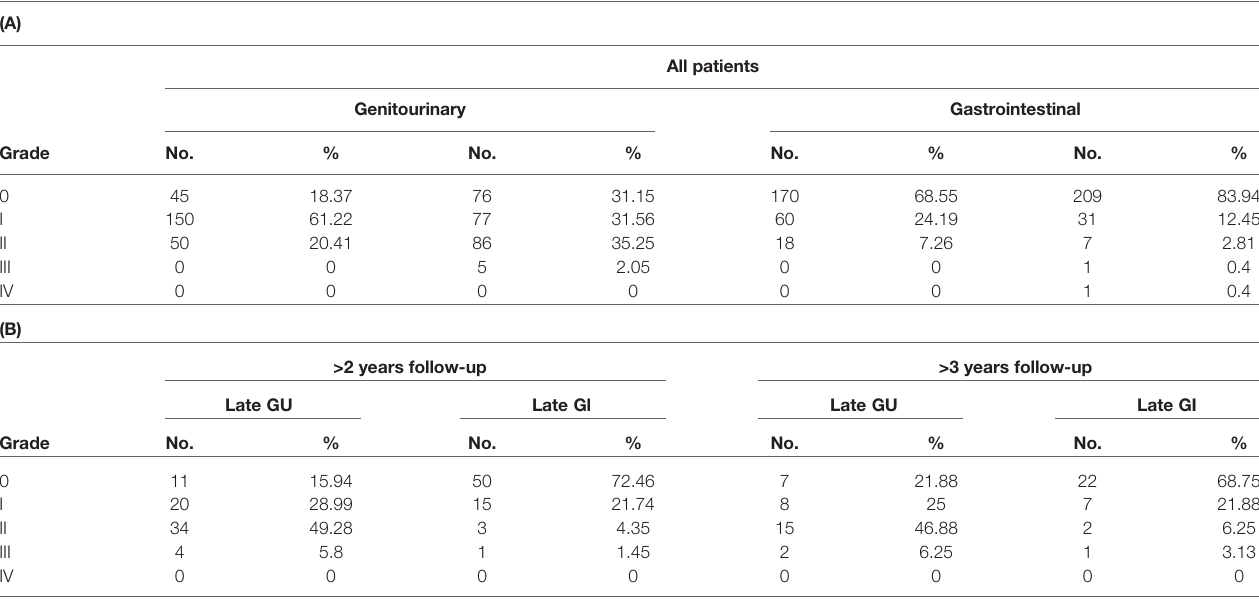
TABLE 3 | Highest reported acute and late toxicities from the start of treatment.